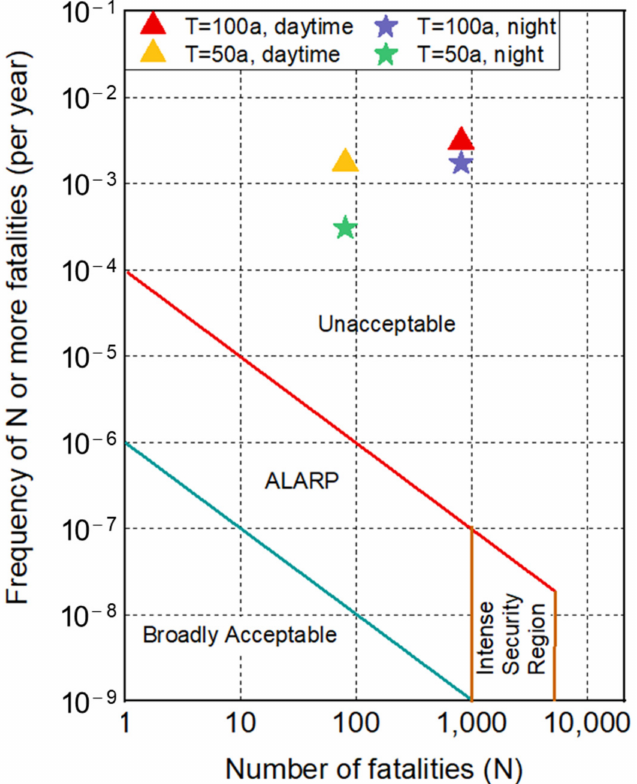
Figure 17. F-N curves for Tianziling landfill after the dump failure. The risk used in the figure was the average